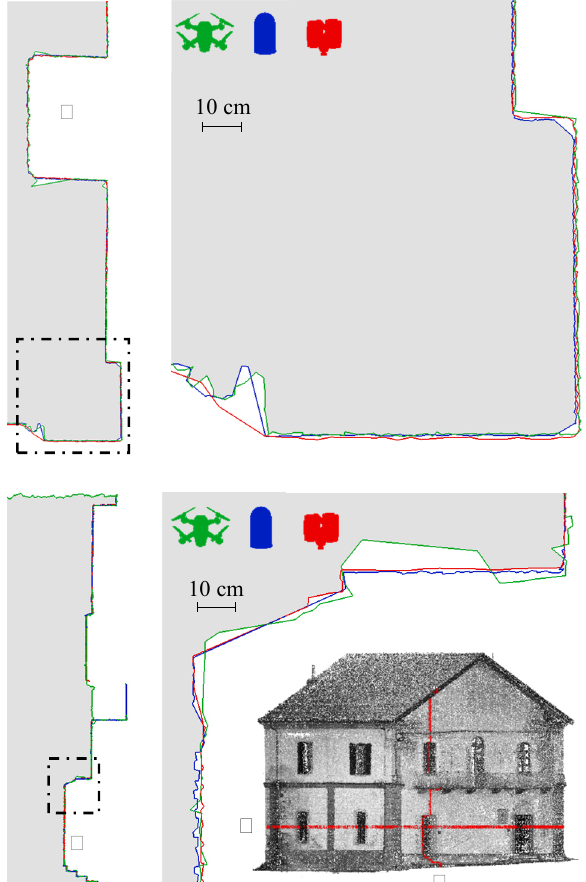
Figure 12. C2C comparison between the X 330 point cloud (ground truth) and the BLK360 for an absolute distance < 30 mm.